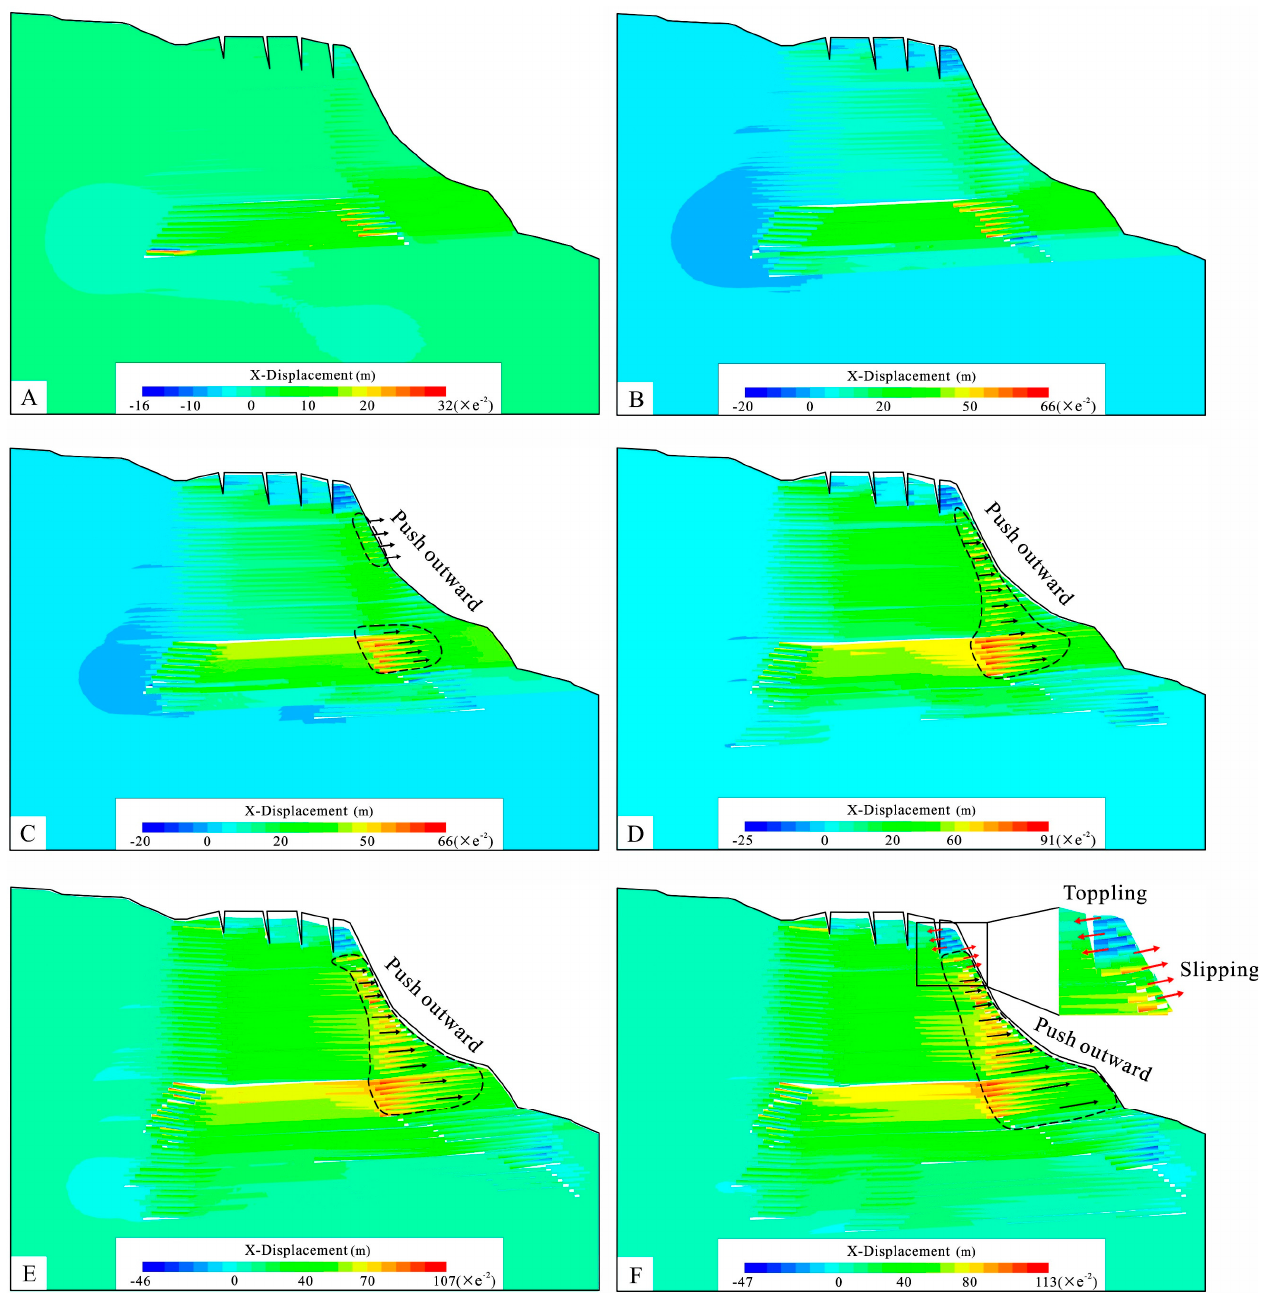
Figure 21. Evolution of horizontal displacement under underground mining conditions: ( A ) mining stages I − II; ( B ) mining stages I − IV; ( C ) mining stages I − VI; ( D ) mining stages I − VIII; ( E ) mining stages I − X; and ( F ) mining stages I − XII. Note: the positive values indicate horizontal displacement towards the outside of the slope.